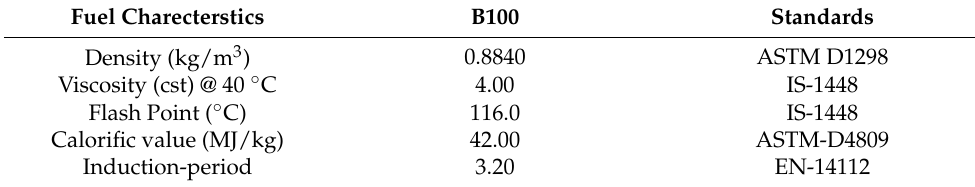
Table 9. Fuel attributes of the produced biofuel.